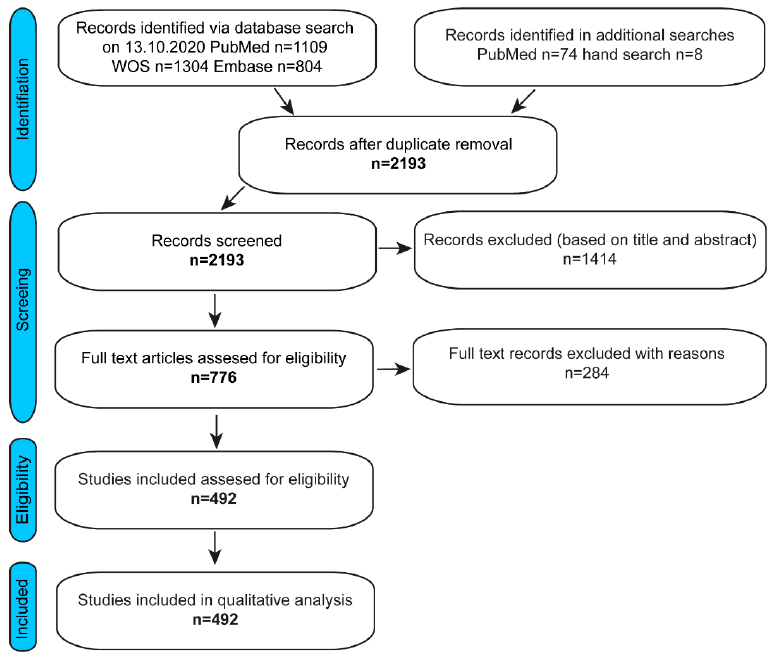
Figure 1. PRISMA chart. Flow diagram presenting the procedure for literature selection.